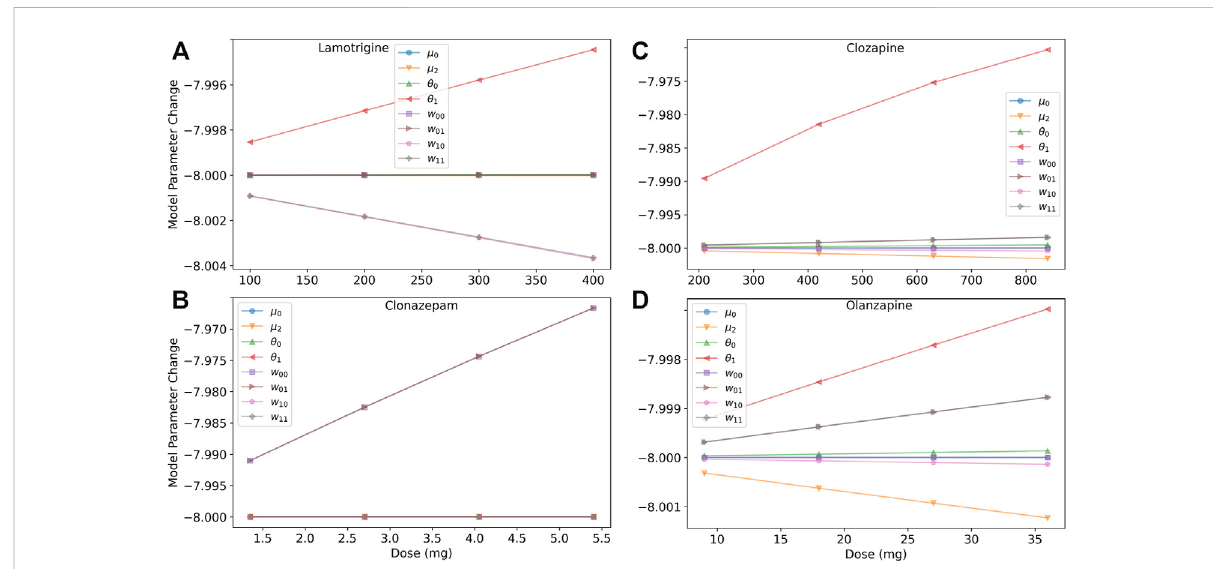
FIGURE 4 Doseresponseofmodelparametersfor lamotrigine,clonazepam,clozapine,andolanzapine. (A) Thedose responseof themodel ’ sparameters for lamotrigine shows that the threshold of excitatory neurons ( θ 1 ) increases with increasing dose leading to a decrease of the neurons ’ excitability. The excitatory synaptic parameters ( w 11 and w 10 ) decrease leading to a reduced excitation of the system. (B) The dose response of the model ’ s parameters for clozapine shows that several parameters are affected, but the largest effect is an increase of the threshold in excitatory neurons ( θ 1 )duetoblockingM1and5-HT2Areceptorsreducingtheexcitationofthesystem. (C) Thedoseresponseofthemodel ’ sparametersforolanzapine shows less of a an increase in the threshold in excitatory neurons than clozapine, and a fi ner scale view of the other model parameters. (D) The